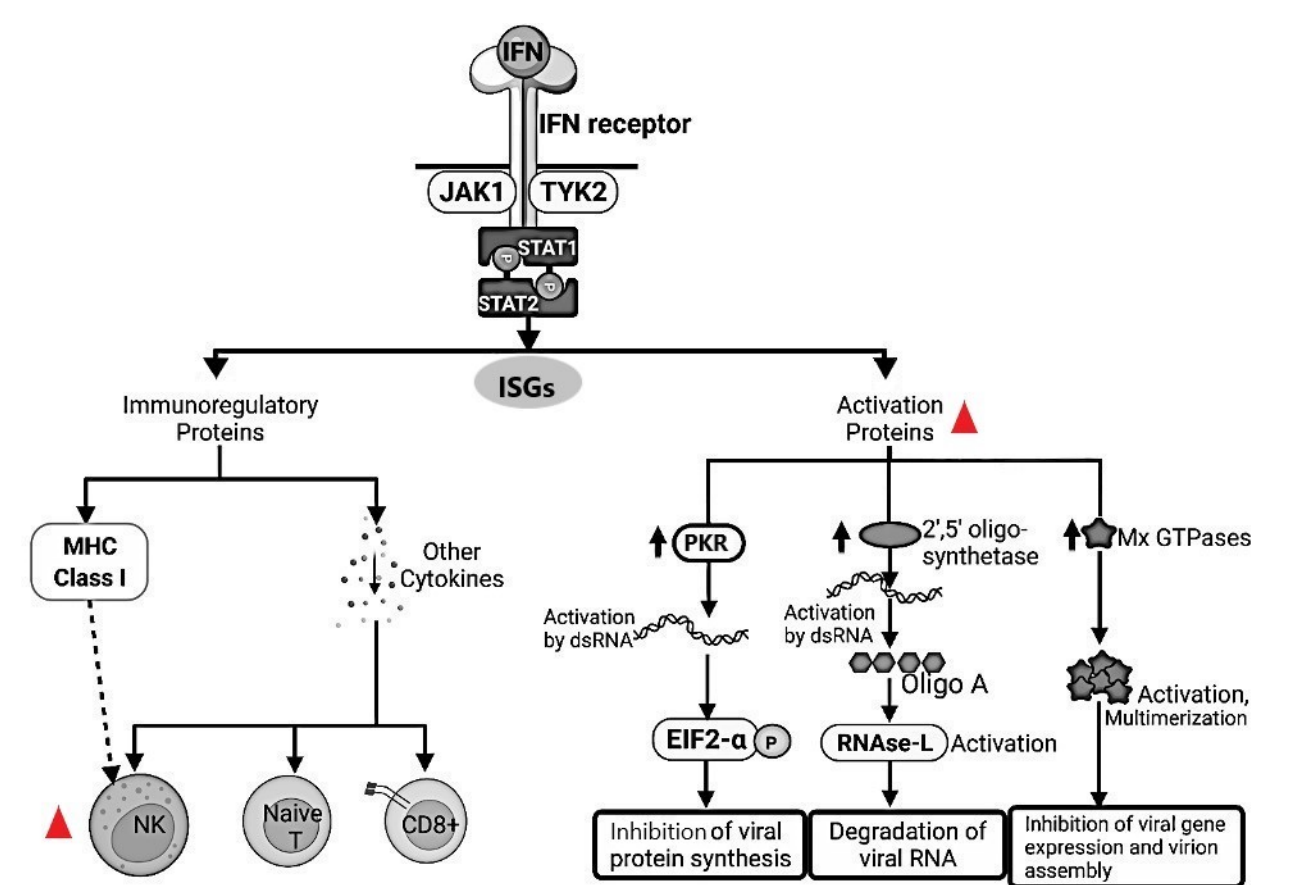
Figure 2. Schematic representation of pathways of type I interferon (IFN) induction and receptor signaling. Type I IFNs bind to receptors (IFNAR) on neighboring uninfected cells and activate JAK-STAT signaling pathways, which induce the expression of genes whose products interfere with viral replication. Type I IFNs also bind to receptors on infected cells and induce expression of genes whose products enhance the cell’s susceptibility to cytotoxic T lymphocyte (CTL)-mediated killing. The pathway targeted by feline coronavirus/feline peritonis virus (FeCoV/FIPV) is highlighted using . FeCoV infection inhibited the type I IFN synthesis that results in an inhibition of the protein synthesis. Natural Killer (NK) cells are drastically depleted from the peripheral blood mesenteric lymph nodes and spleen in FIPV-infected cats. Moreo- ver, NK showed less cytotoxic activity in FIP-infected cats. dsRNA , Double-stranded RNA; PKR , Double-stranded RNA-activated protein kinase, EIF2-a, Eukaryotic translation initiation factor 2A; RNAse-L , Ribonuclease L; MHC , Major His-